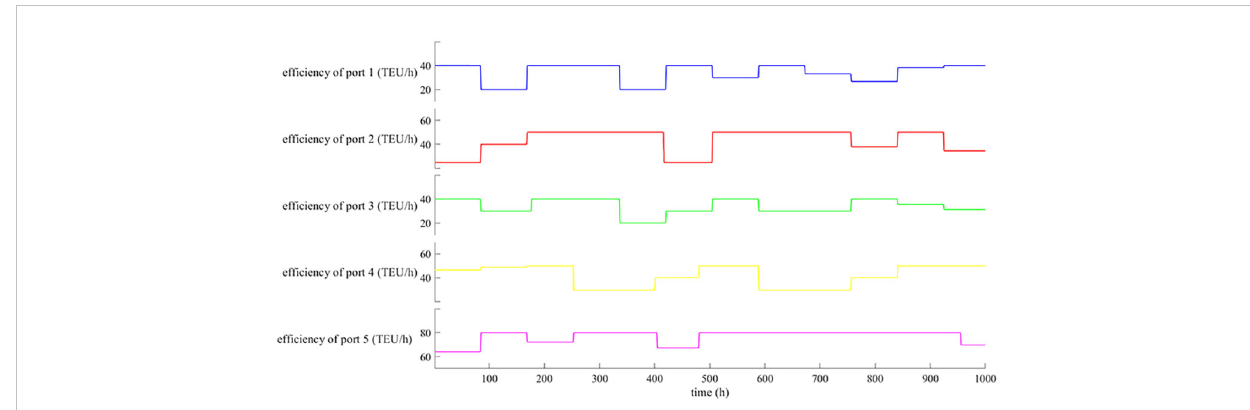
FIGURE 4 Real-time handling ef fi ciency of each port.